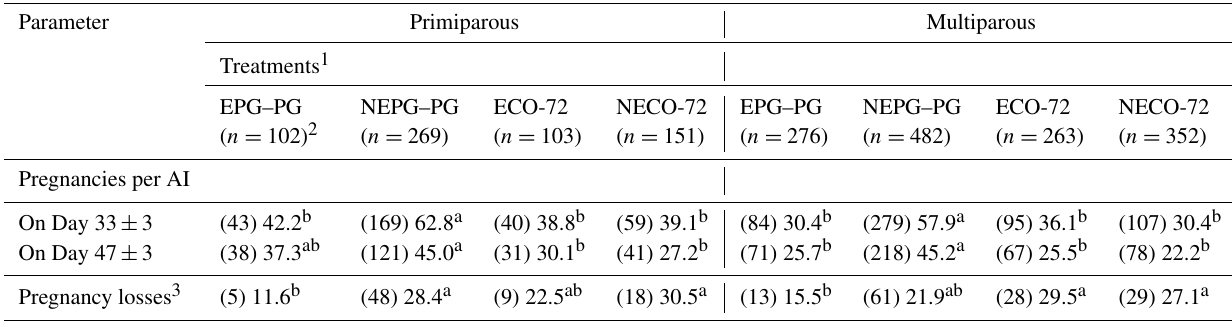
Table 5. Pregnancies per AI and pregnancy losses for cows based on treatment–parity